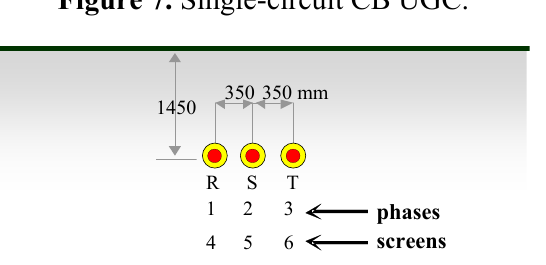
Figure 7. Single-circuit CB